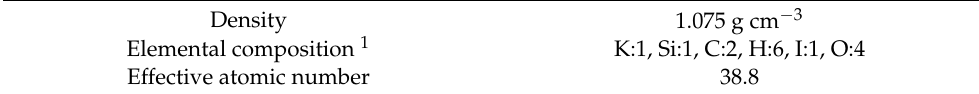
Table 1. Physico-chemical properties of PAISiN.